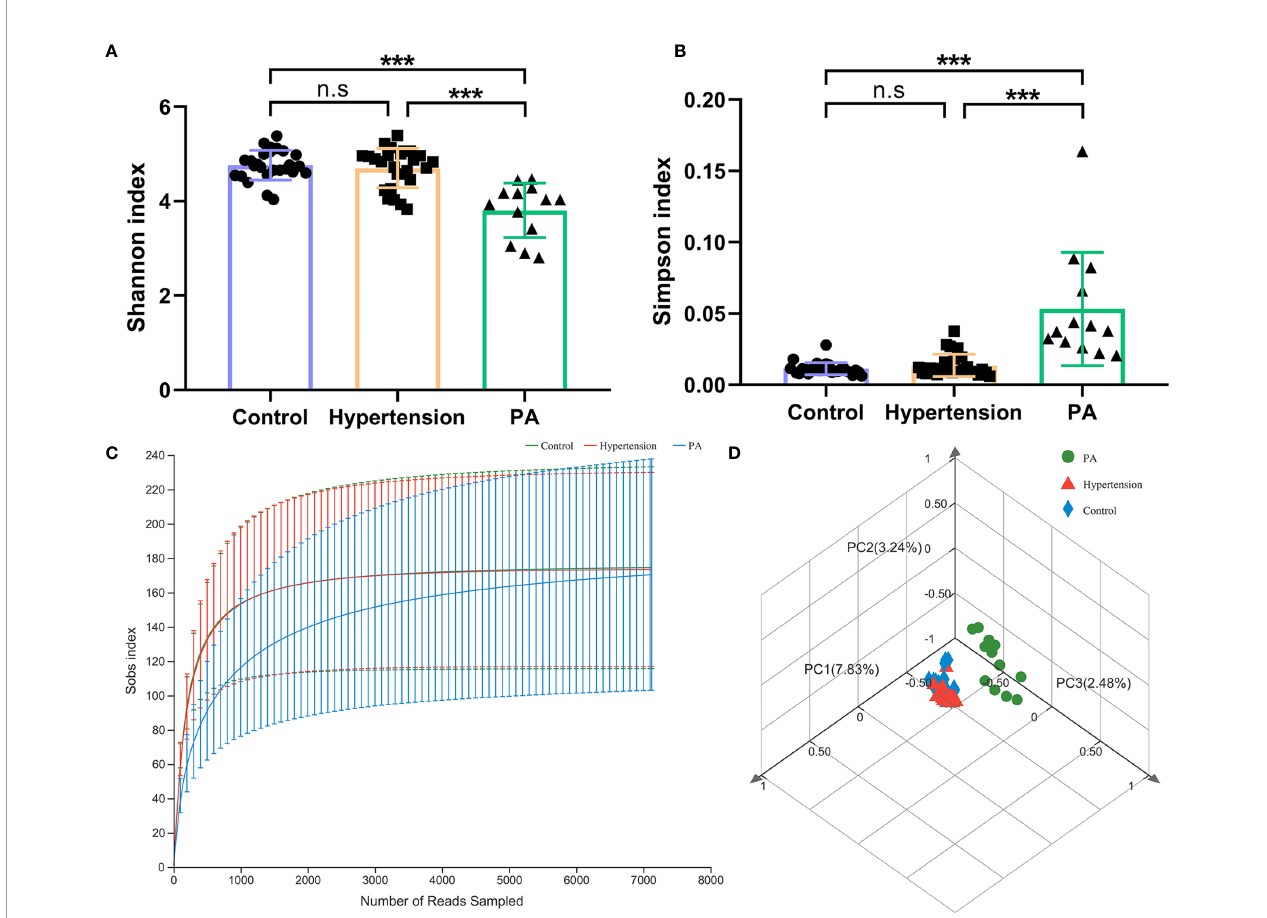
FIGURE 1 | Diversity of the gut microbiota in primary aldosteronism (PA) patients, primary hypertension patients, and healthy controls. (A) Shannon index and (B) Simpson index of gut microbiota. (C) Rarefaction curves of all the samples in the three groups. The horizontal axis shows the number of sequences obtained by sequencing the 16S rRNA gene. The vertical axis shows the number of genera. (D) PCoA of gut microbiota by Bray – Curtis distance. *** p < 0.001. n.s, not signi fi